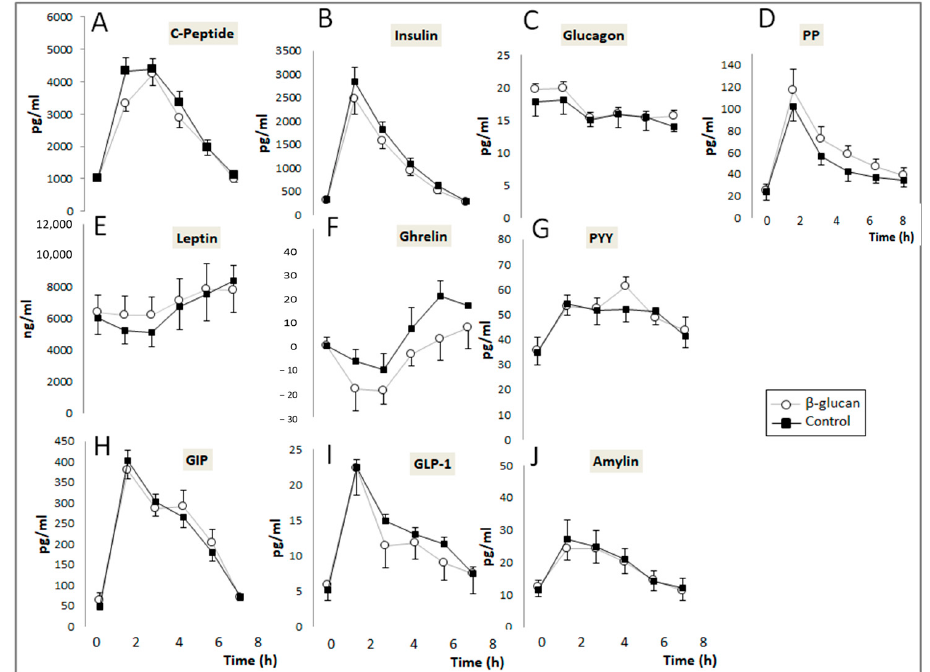
Figure 3. Post-prandial changes in the plasma concentrations of digestive hormones. A – C -peptide (Treatment (Trt.) × Time: p = 0.75); B —Insulin (Trt. × Time: p = 0.25); C —Glucagon (Trt. × Time: p = 0.94); D —PP (Trt. × Time: p = 0.83); E —Leptin (Treatment (Trt.) × Time: p = 0.95); F —Ghrelin (Trt × Time: p = 0.88); G —PYY (Trt. × Time: p = 0.042); H —GIP (Trt. × Time: p = 0.87); I —GLP-1 (Trt. × Time: p = 0.79); J —Amylin (Trt. × Time: p = 0.90). (Means ± SEM). Two-way ANOVA for repeated measurements (Treatment X time interaction). Table 3. The area under the curves (AUC) of post-prandial plasma concentrations of digestive hormones and glucose during the control and β -Glucan periods (Means (CI 95% )).